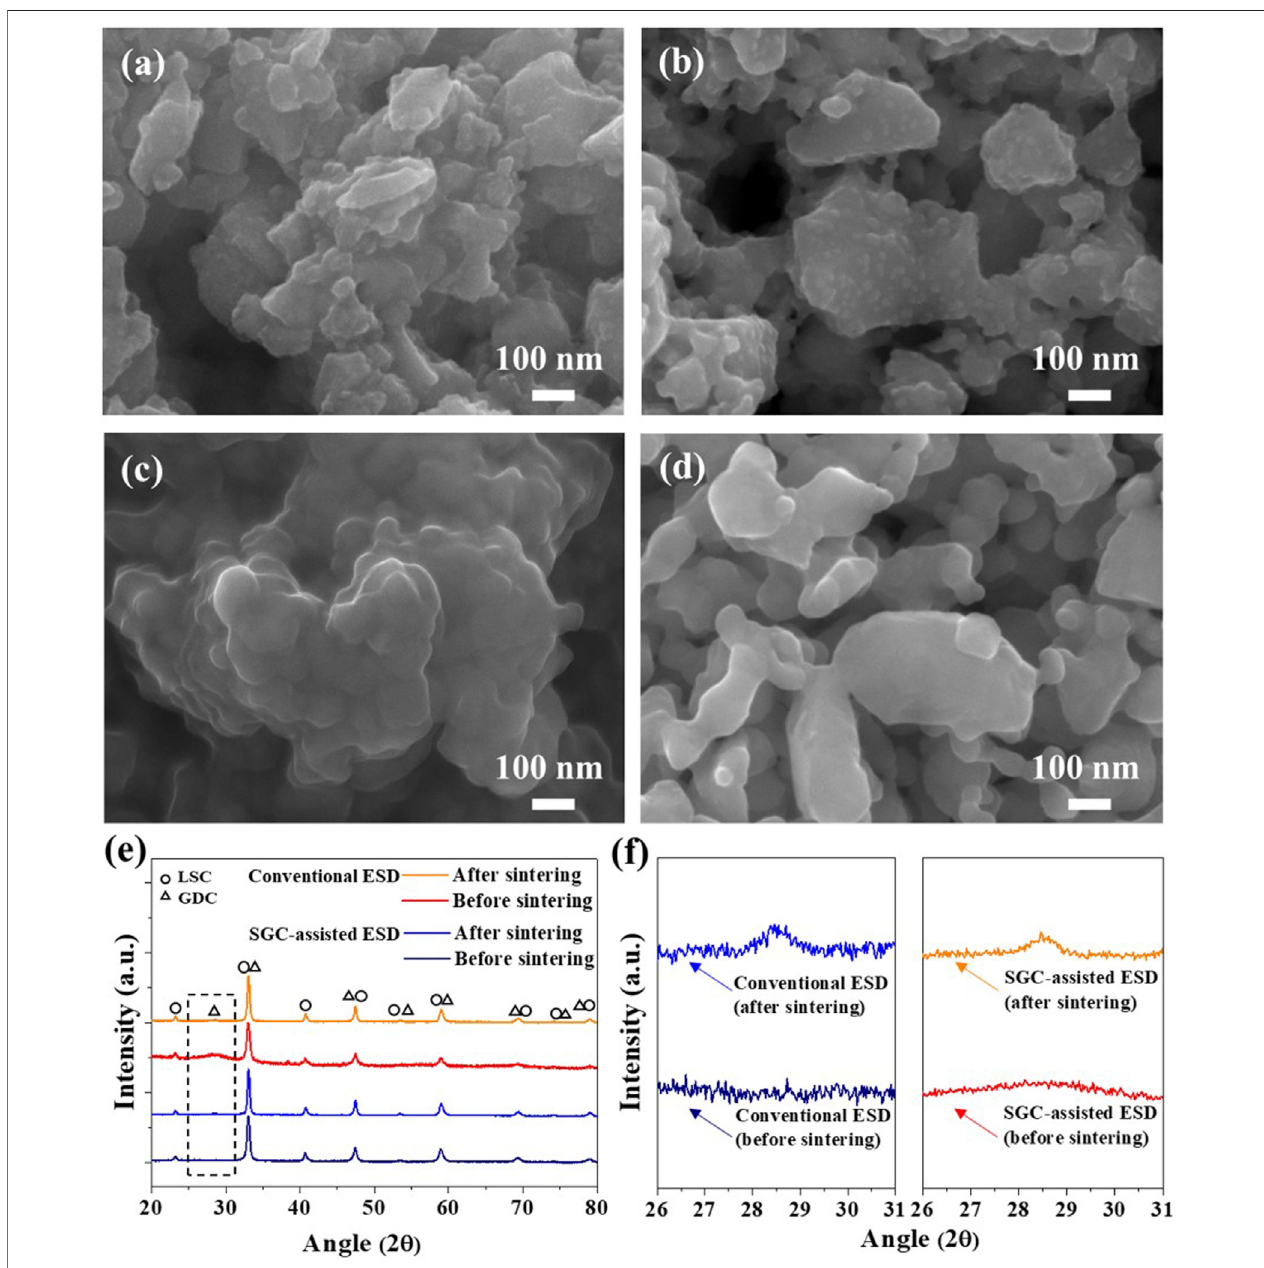
FIGURE 3 | SEM images of LSC-GDC powders using conventional ESD (A) before and (B) after sintering at 800 ° C, and LSC-GDC powders using SGC-assisted ESD (C) before and (D) after sintering at 800 ° C. (E,F) XRD patterns of fabricated LSC-GDC powders.